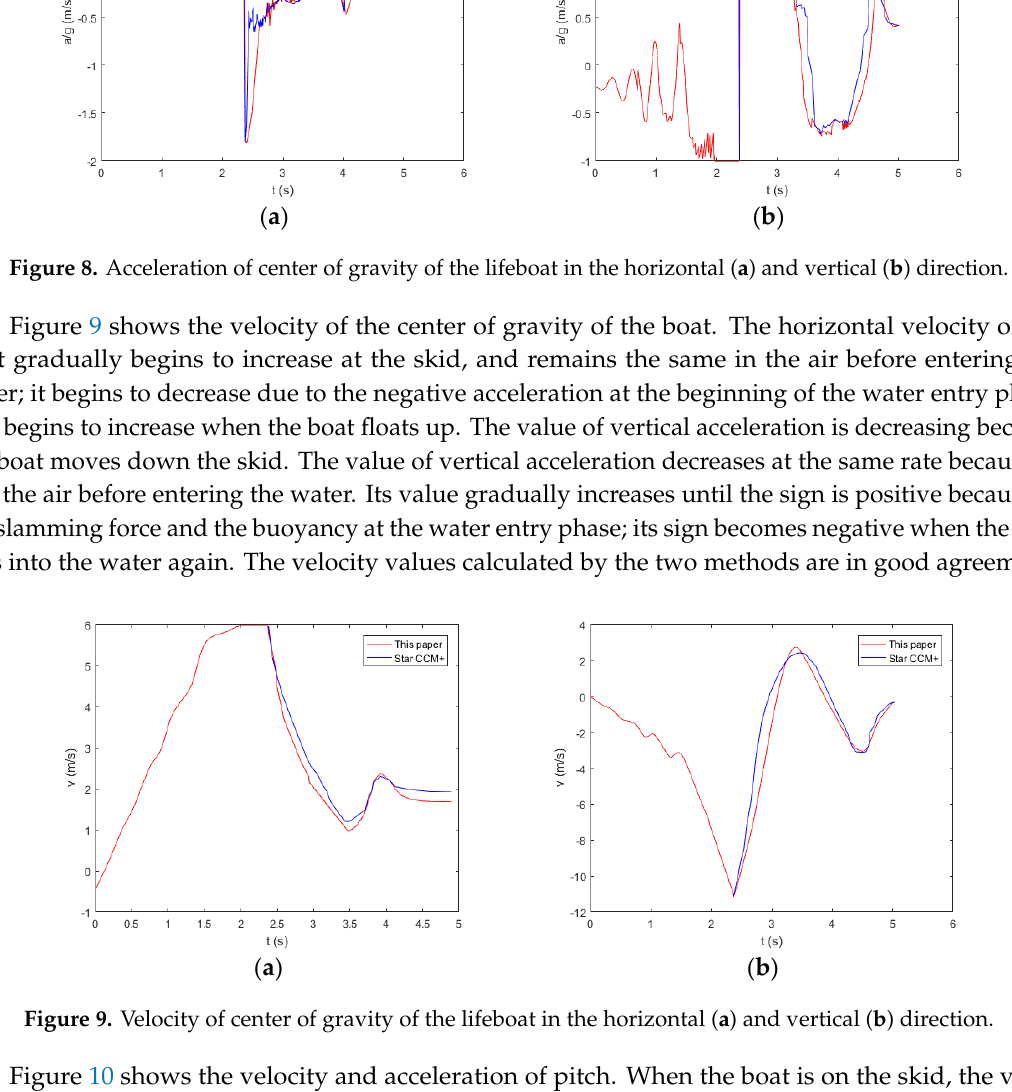
Figure 7. Trajectory ( a ) and pitch ( b ) of the lifeboat freefall during its launch from the ship.